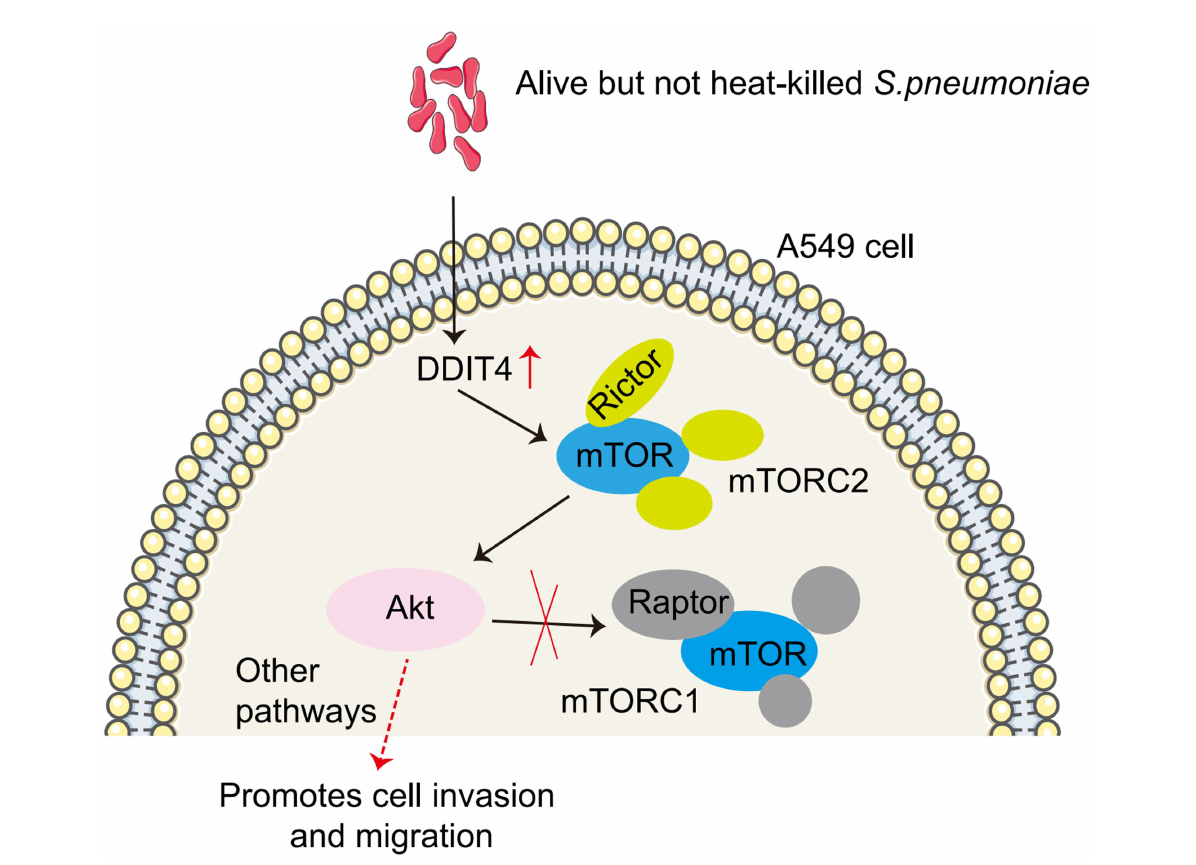
FIGURE 6 Model of S. pneumoniae up-regulates DDIT4 expression in A549 cells, which activates the mTORC2/AKT signaling